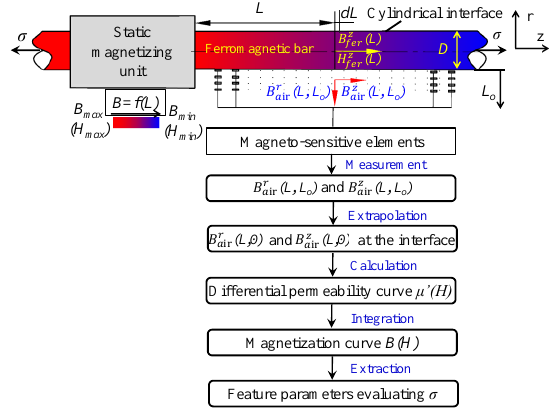
Figure 1. The principle of the proposed steel stress measuring sensor.